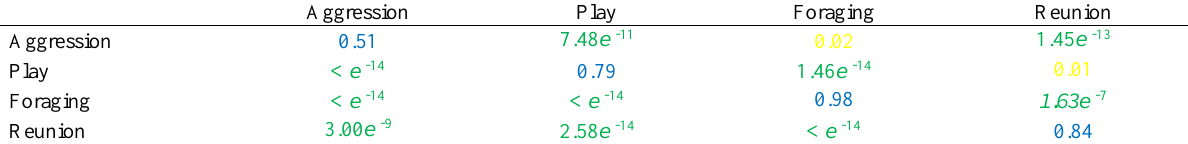
The p-values for the statistical testing experiment using the small dataset and the exact algorithm Aggression Play Foraging Reunion Aggression 0.26 Play < e -14 0.23 Foraging < e -14 0.27 0.91 < e -14 Reunion 3.0 e -5 < e -14 < e -14 0.26